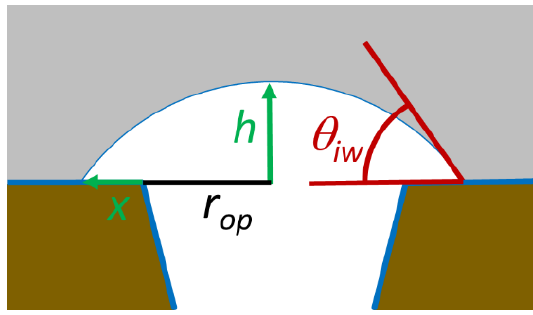
Figure 10. Growth of ice out of the pore as a spherical cap with an increasing height h covering an increasing area π(r op + x) 2